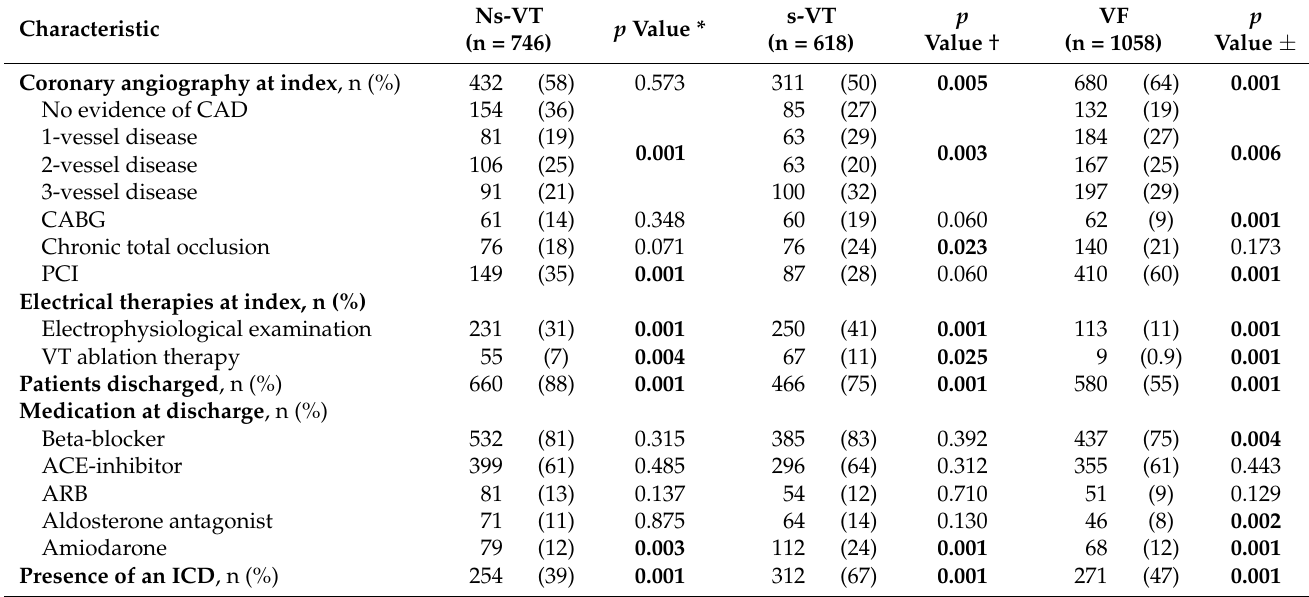
The distribution of the types of initial ventricular tachyarrhythmias stratified by the underlying cardiac disease is outlined in Figure 2. Thus, VF was most common in patients presenting with AMI (64%), whereas the rates of s-VT were highest in the IHD group (35%). Ns-VT was most common in patients with NICMP (39%).